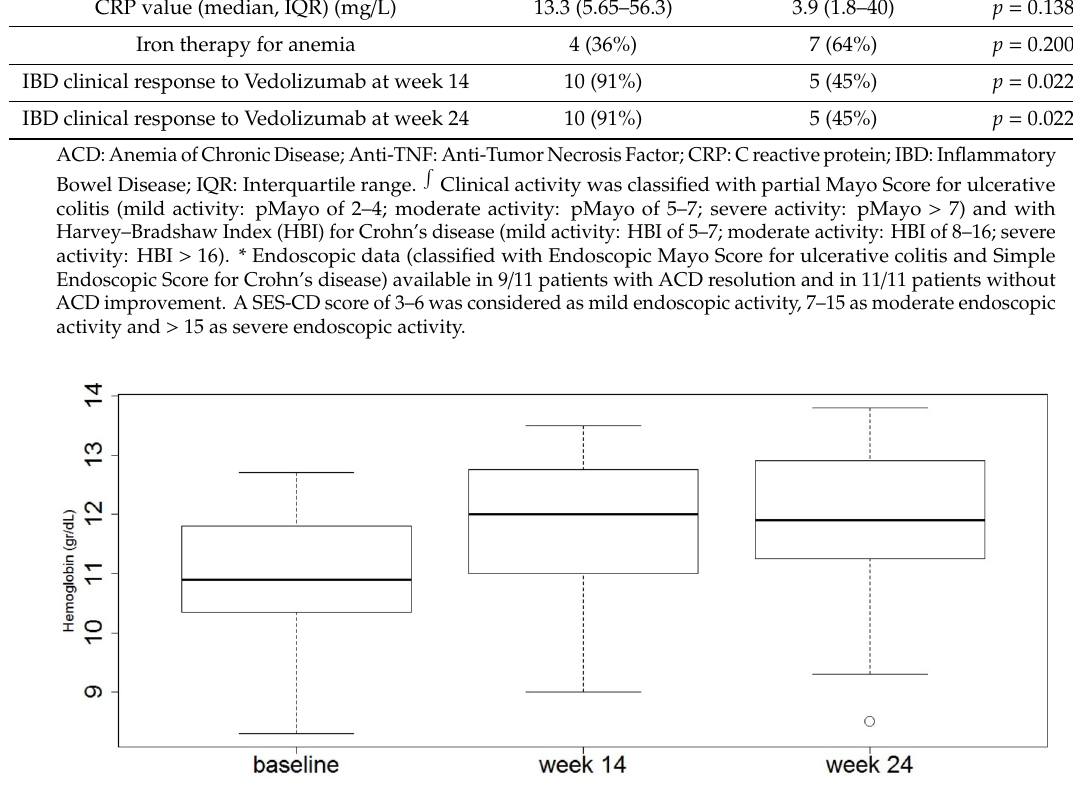
Figure 1. Vedolizumab treatment enhances hemoglobin values in patients with inflammatory bowel disease. The box-plots show the median values and the interquartile ranges at baseline and at week 14 and week 24 following Vedolizumab treatment in the total ACD population. Baseline vs. week 14, p = 0.016; baseline vs. week 24, p = 0.18.